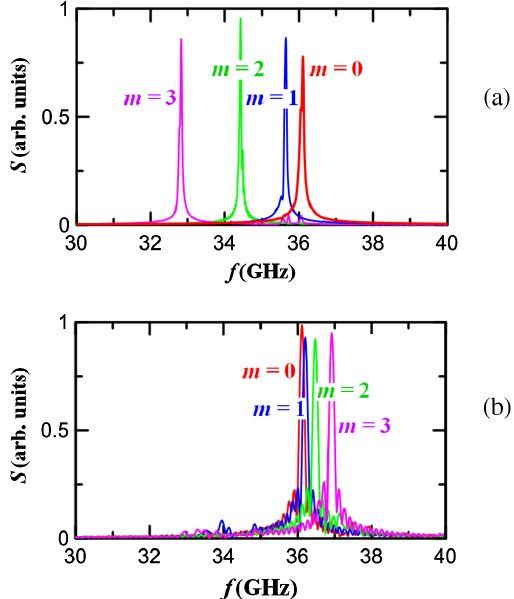
FIG. 3. Field spectra corresponding to excitation of different azimuthal eigenmodes by an initial rf pulse in the cylindrical slow-wave structures having (a) 2D and (b) 1D corrugation ( CST simulations). Parameters of the 2D structure are shown in Table I. Parameters of the 1D structure are as follows: mean cavity radius of 23 mm, length of 87.5 mm, corrugation of the period of 3.5 mm and depth of 1.8 mm.